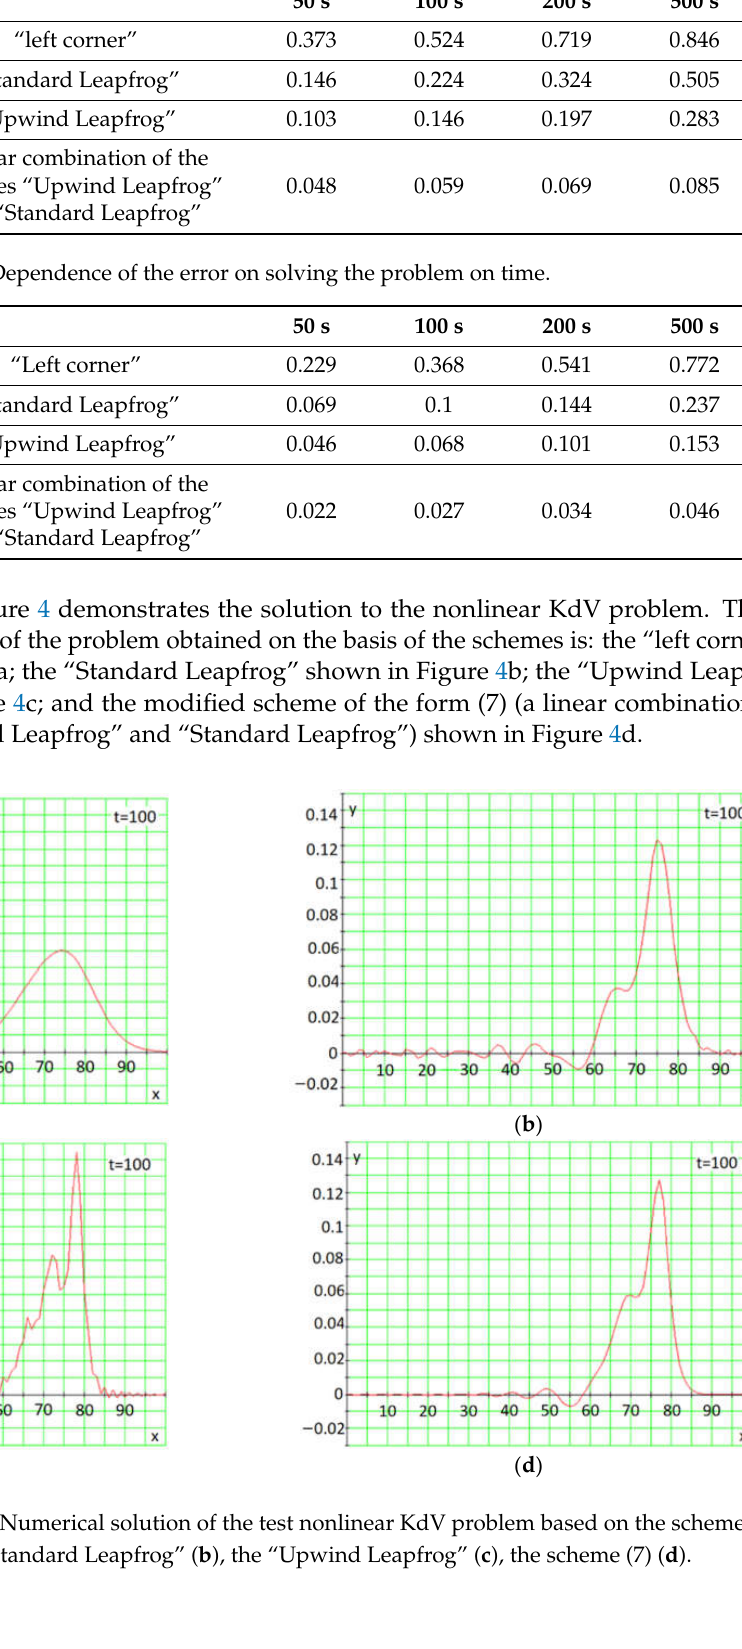
( b ) Figure 5. Dynamics of the solution of the KdV problem at the initial distributions in the bell ( a ) and kink ( b ) solitary wave solution form; red line—initial distribution, burgundy line—after 25 s, pink line—after 50 s, light blue line—after 75 s, blue line—100 s. According to the graphs shown in Figure 5, we can follow the changing shape of the curve to solve the KdV problem and its shift along the Ox axis at